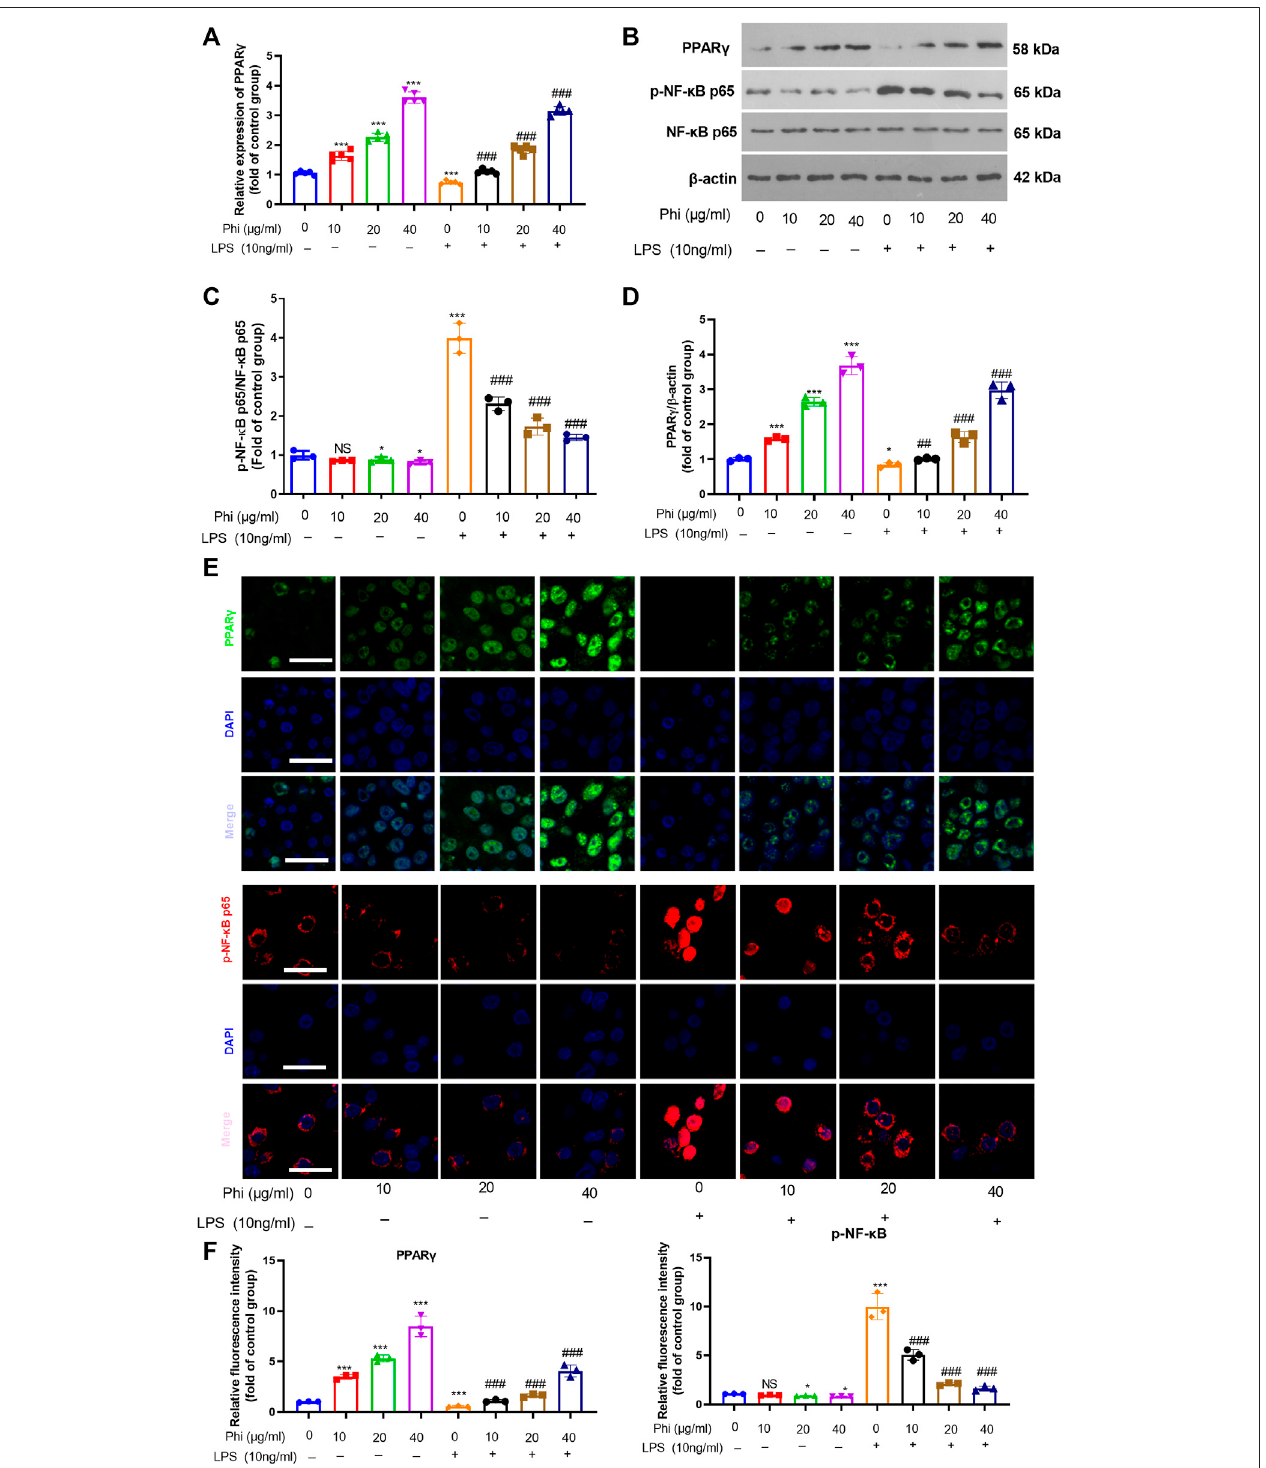
FIGURE 2 | Effects of Phi on the PPAR γ /NF- κ B pathway in microglia under LPS stimulation. Microglia were treated with LPS (10 ng/ml) and/or Phi (40 μ g/ml) for 4 h. (A) The PPAR γ mRNA level in microglia was evaluated by RT-PCR. (B – D) Western blot was conducted to detect phospho-NK- κ B p65, PPAR- γ in microglia. (E , F) Immuno fl uorescence was carried out to detect phospho-NK- κ B p65, PPAR- γ in microglia. The relative fl uorescence intensity of phospho-NK- κ B p65 and PPAR- γ was analyzedbyImageJ.Thevalueswereexpressed asmean ± SD.NS p > 0.05,* p < 0.05,** p < 0.01*** p < 0.001vs.thecontrolgroup;## p < 0.01,### p < 0.001vs. the LPS group. n (cid:1) 5/group.